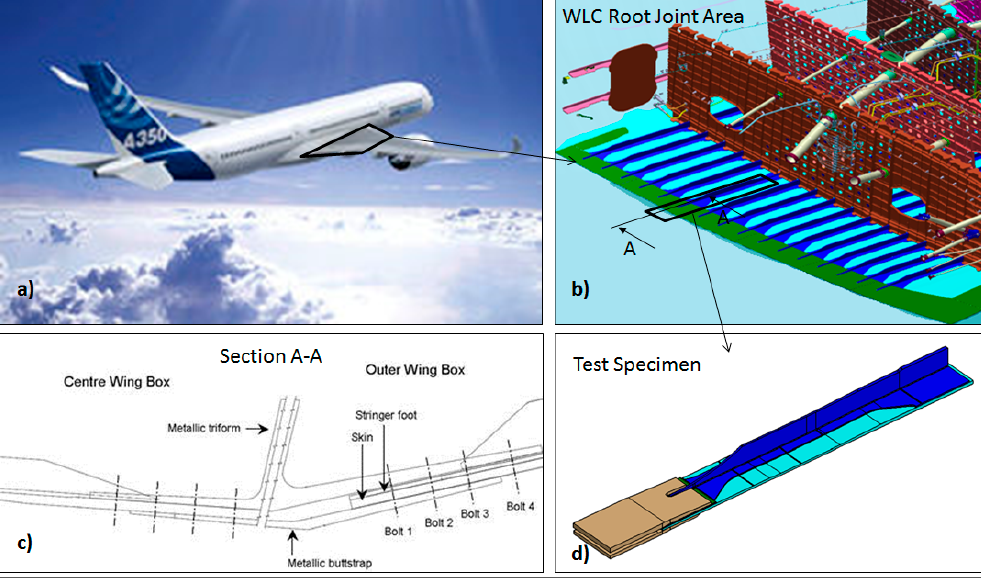
Figure 2. ( a ) Full aircraft, ( b ) Wing Lower Cover Root Joint Area, ( c ) Section A-A of Root Joint Area and ( d ) Test specimen